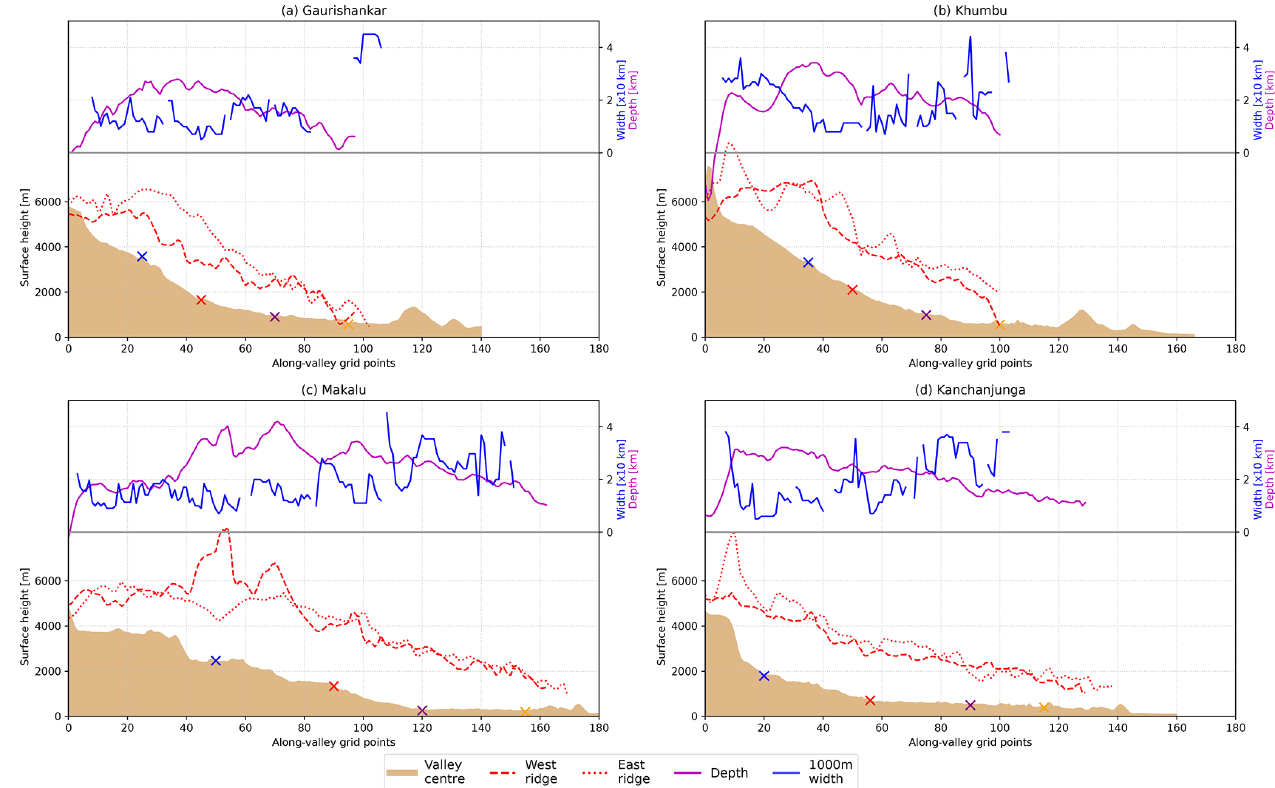
Figure 3. The height profiles (brown shading) of the valley centre lines (yellow lines in Fig. 2b) and the ridgelines (red dashed lines) correspond to the values on the left y axis. Cross-valley width at an elevation of 1000m above the valley centre line is shown using the blue line. The valley depth is described as the height difference between the centre line and average of the ridgelines (shown in purple). The lines for width and depth correspond to the values on the right y axis. Each panel shows one valley: (a) Gaurishankar (most westerly valley), (b) Khumbu, (c) Makalu and (d)